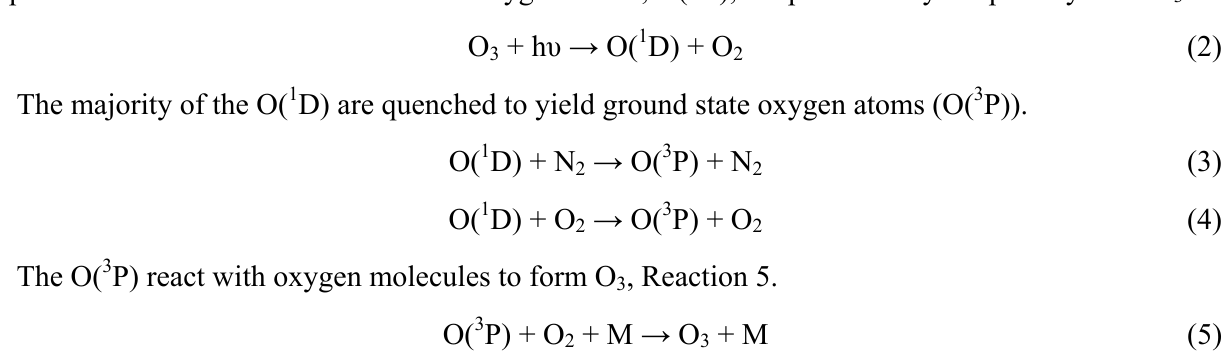
Figure 2. Excited oxygen atom (O( 1 D)) for the O